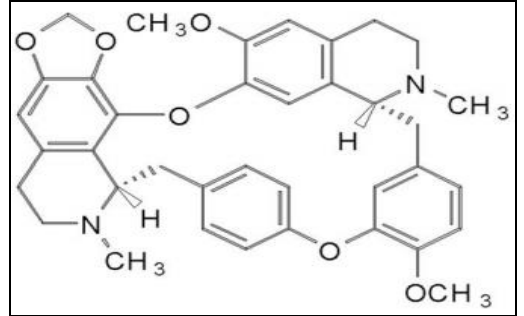
Figure 12. Chemical structure of Cepharanthine (98) Other natural